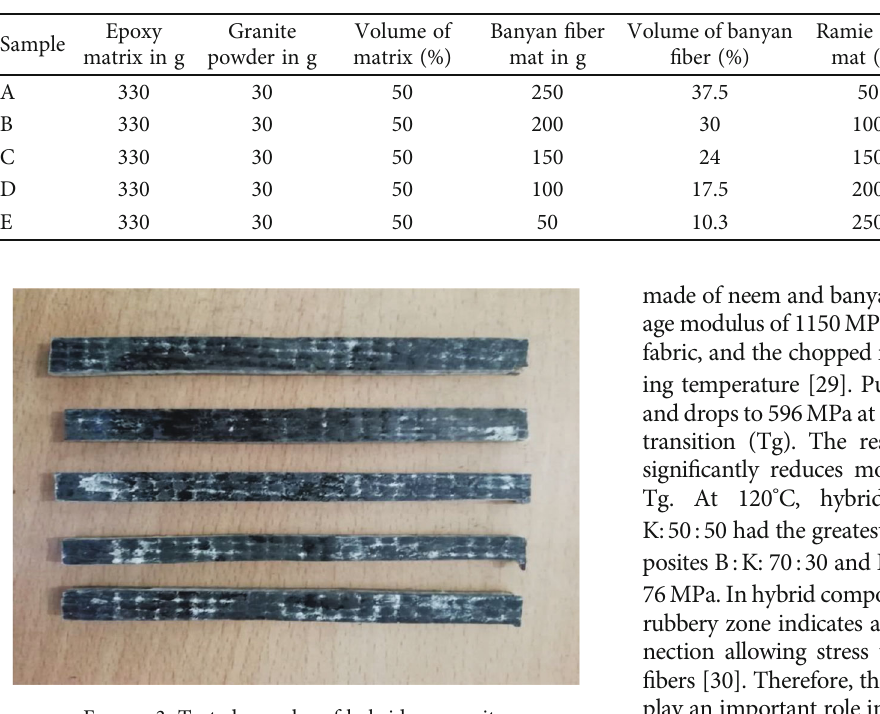
Figure 3: Tested samples of hybrid